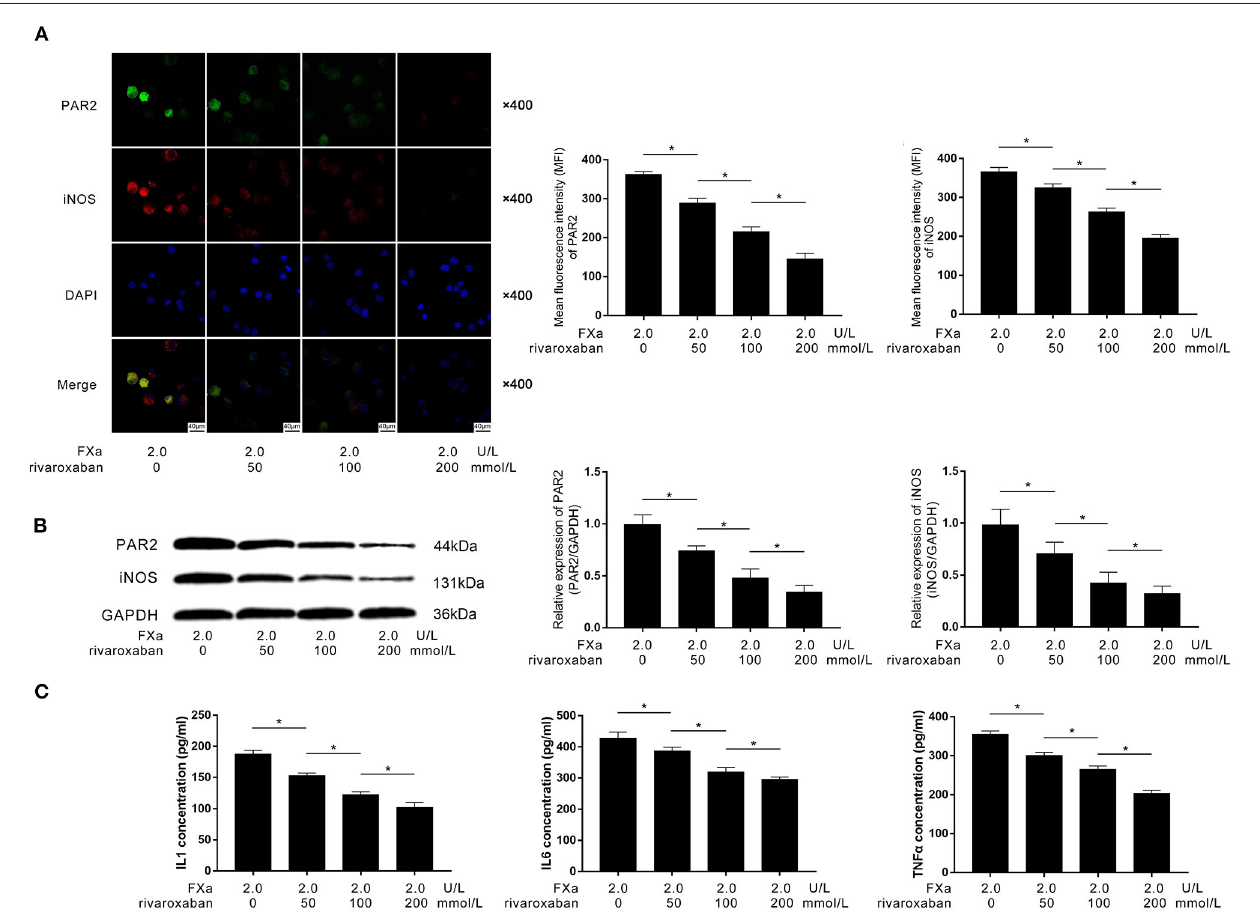
FIGURE 5 | (A) Immunofluorescence stains of PAR2, iNOS, ad DAPI and their merged images of macrophages are demonstrated. Columns indicated the mean fluorescence intensity of PAR2 and iNOS of macrophages exposed to FXa at 2.0 U/L and treated with rivaroxaban at concentrations of 0, 50, 100, and 200 mmol/L. (B) Immunoblots of PAR2, iNOS, and GAPDH. Columns indicate the relative expression levels of PAR2 and iNOS in macrophages exposed to FXa at 2.0 U/L and treated with rivaroxaban at concentrations of 0, 50, 100, and 200 mmol/L. (C) Columns indicate the concentrations of IL1, IL6, and TNF α in the cell culture medium of macrophages exposed to FXa at 2.0 U/L and treated with rivaroxaban at concentrations of 0, 50, 100, and 200 mmol/L (data were presented as mean ± SD, n = 6, Student’s t -test and ANOVA, * P <